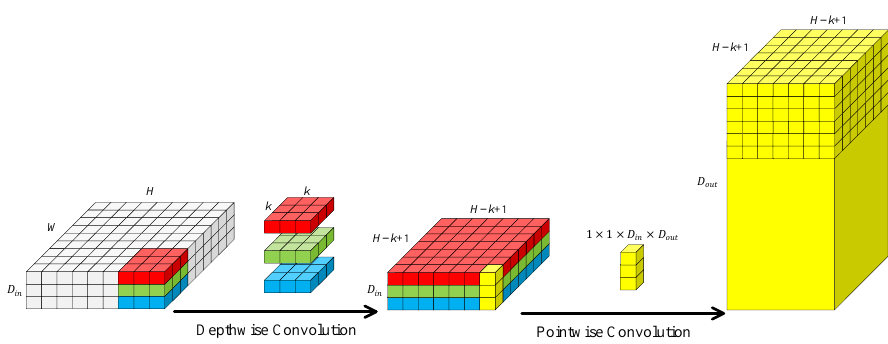
Figure 2. Schematic of depthwise separable convolution.